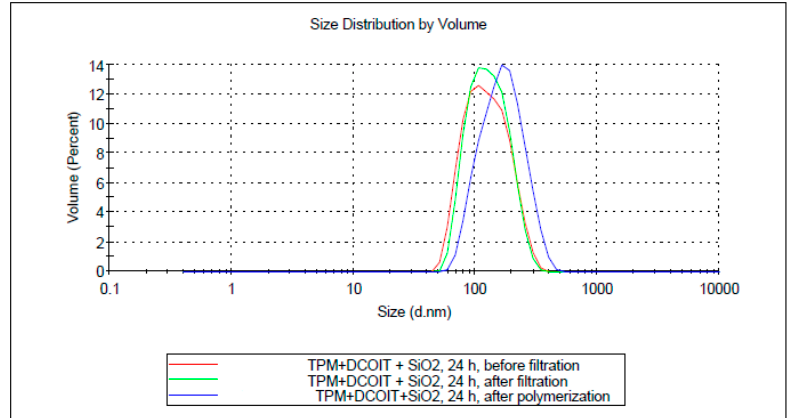
Figure 1. Size distribution curves of Pickering emulsion submicro-containers (SMCs) with a shell of silicon dioxide nanoparticles and a core of substituted polymerized 3- (trimethoxysilyl) propyl methacrylate (TPM) with 5-dichloro-2-n-octyl-4-isothiazolin-3-one (DCOIT) before and after polymerization [22].